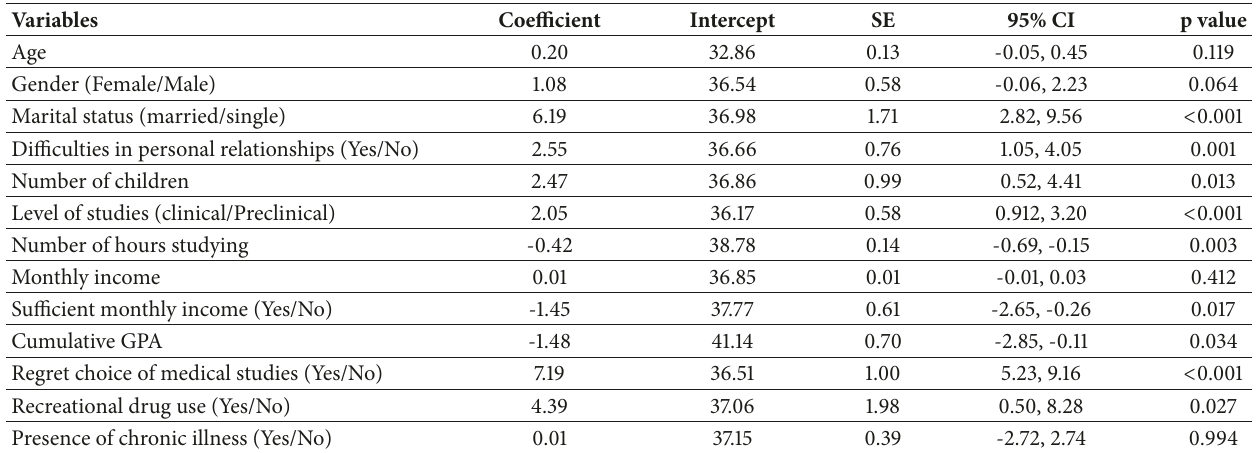
Table 3: Univariable linear regression analysis of potential determinants of burnout syndrome amongst 413 medical students who were assessed for burnout syndrome from January to March 2018 in Cameroon.